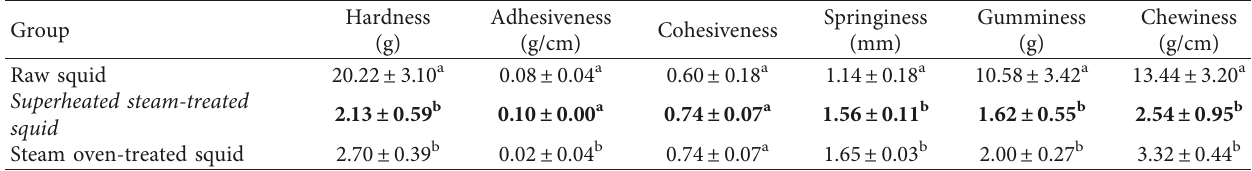
Table 5: Textural properties of raw, superheated steam-treated, and steam oven-treated squid. Group